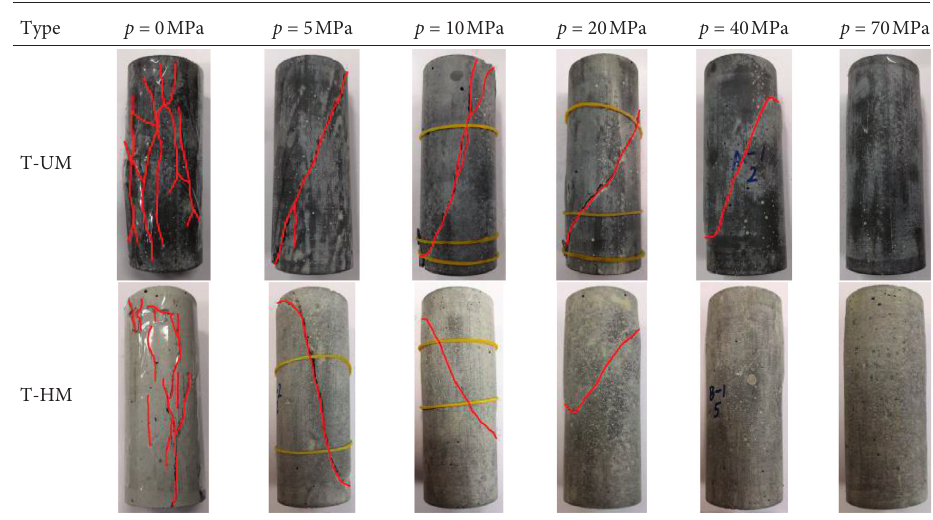
Figure 7: Failure modes of specimens tested by TMM under different confinements.